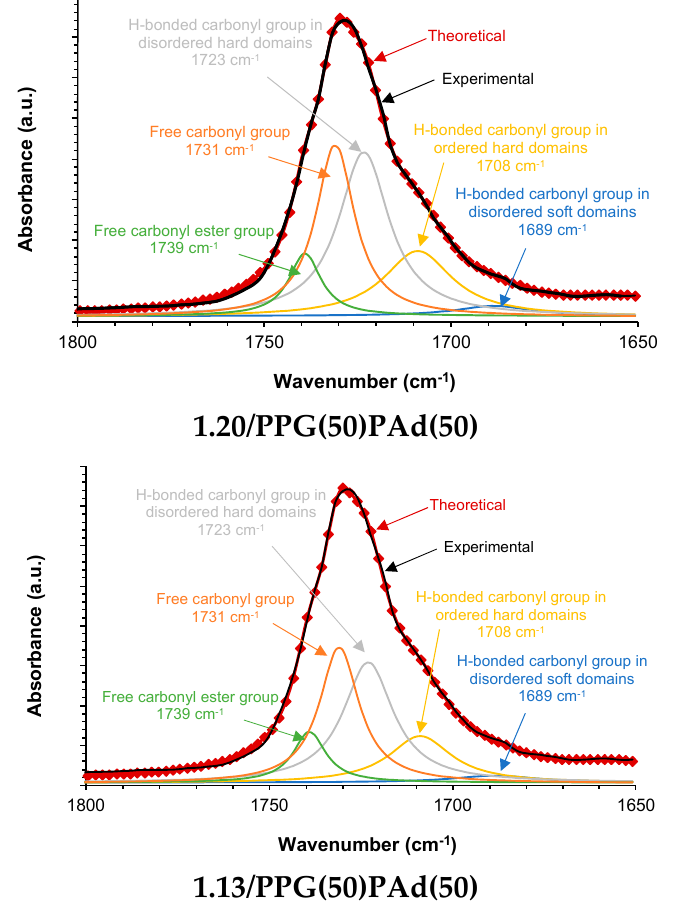
Figure A6. Curve fitting of the carbonyl region of the ATR-IR spectra of the TPUs synthesized with